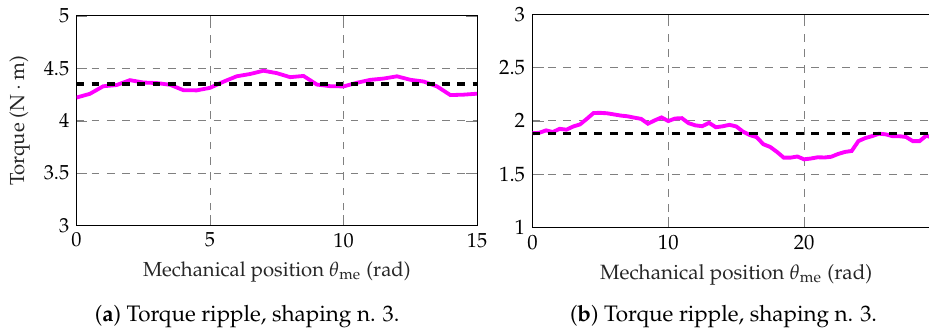
( a ) Torque ripple, shaping n. 3. ( b ) Torque ripple, shaping n. 3. Figure 20. HE-IPM torque ripple with the rotor-shaping solution. Figure 20. HE-IPM torque ripple with rotor shaping solution. Figure 20. HE-IPM torque ripple with rotor shaping solution. Table 4. Mechanical characteristics data comparison. Table 4. Mechanical characteristics data comparison. Parameter Parameter 8 poles